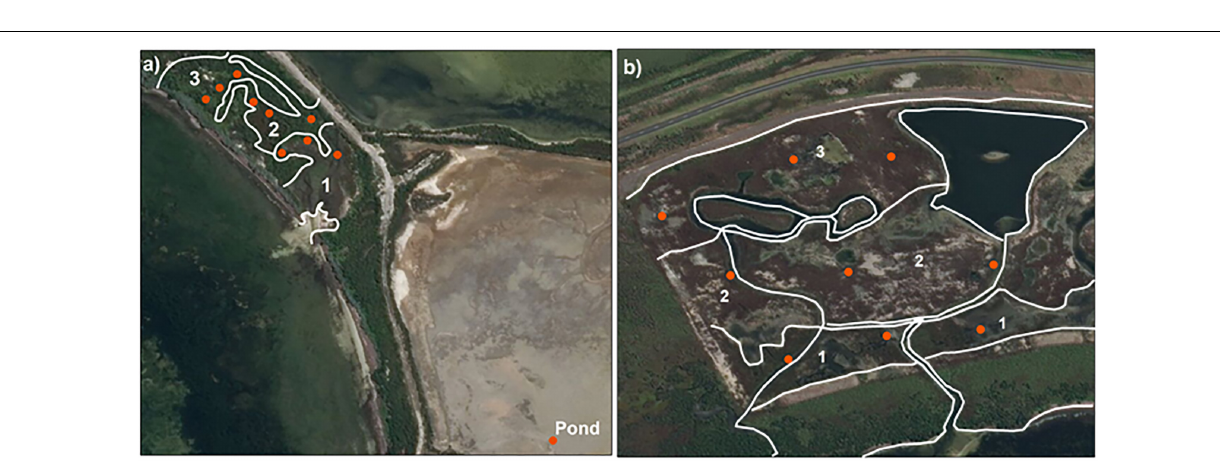
Frontiers in Marine Science |